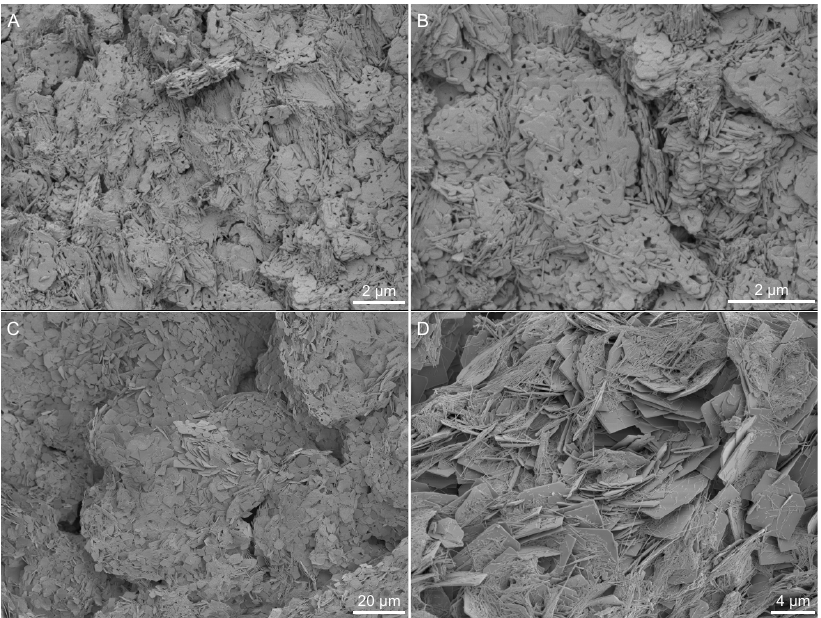
Figure 5. SE-SEM micrographs of the pyroaurite horizon found at 2-cm depth in the Bio-plot after 11 weeks showing ( A ) the relatively poor crystallinity of the pyroaurite indicated by subhedral platelets; and ( B ) the disarticulated chrysotile fibers found among the pyroaurite crystals. Secondary electron micrographs of the carbonate horizon found from 2–4 cm depth in the Bio-plot after 11 weeks showing ( C ) the extent of platy hydromagnesite mixed with ( D ) residual chrysotile fibers.